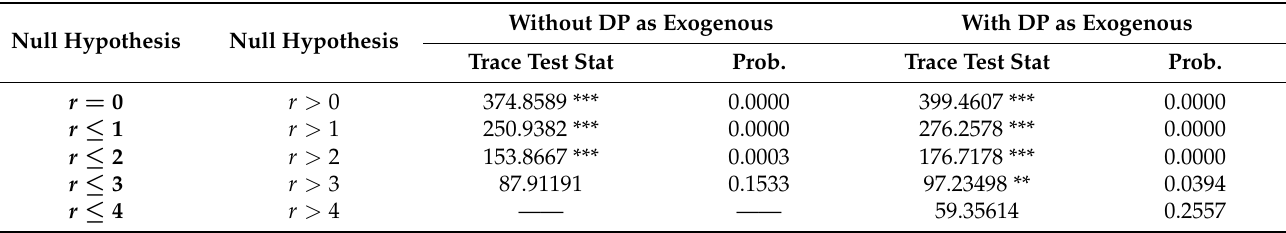
Table 4. Johansen Co-integration Test Results.